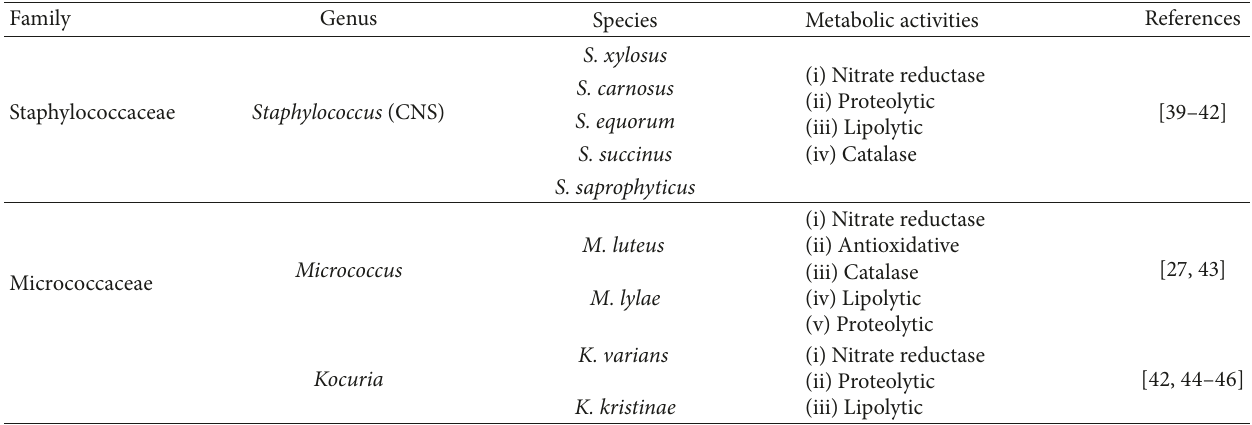
Table 2: Species of GCC+ isolated from fermented sausages and their role in the fermentation process.